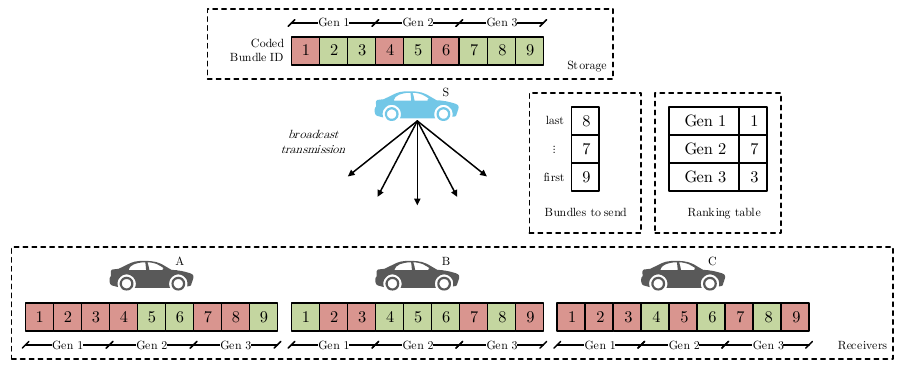
Figure 5. Forwarding decision of LRGF strategy—1st situation—example.